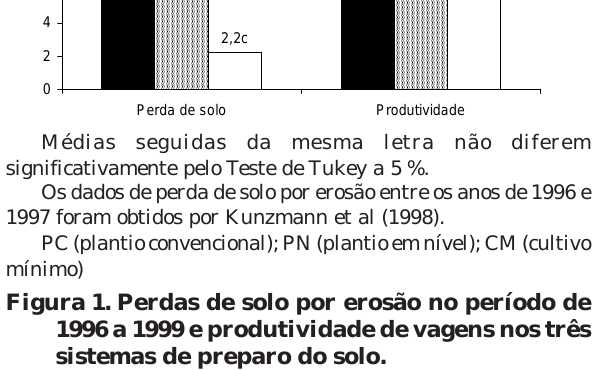
Figura 1. Perdas de solo por erosão no período de 1996 a 1999 e produtividade de vagens nos três sistemas de preparo do